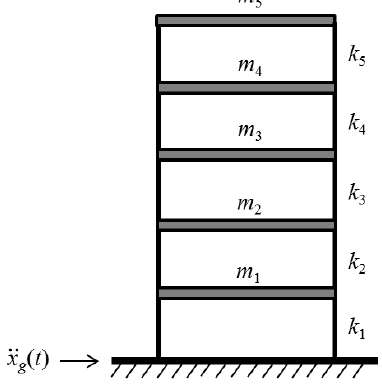
Figure 2. Five-story building model in the numerical example.